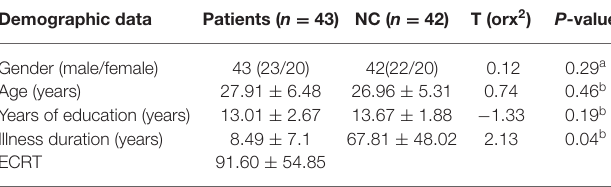
TABLE 1 | Characteristics of the participants. Demographic data